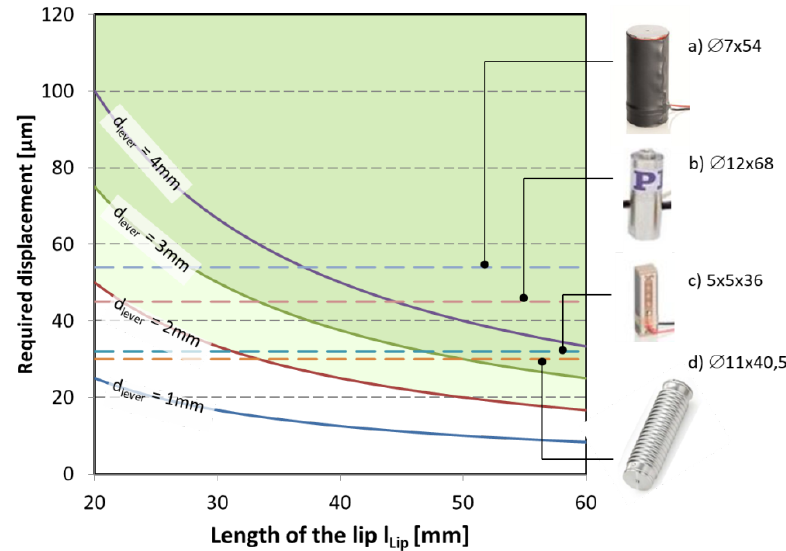
Figure 5. Required actuator stroke and lip length for various leverages (d lever ) to achieve a deflection of 0.5 mm at the lip tip, compared with the stroke of di ff erent commercial stack actuators. ( a ) High voltage stack actuator type P-010.40 [18]; ( b ) High voltage stack actuator with housing type P-841.3